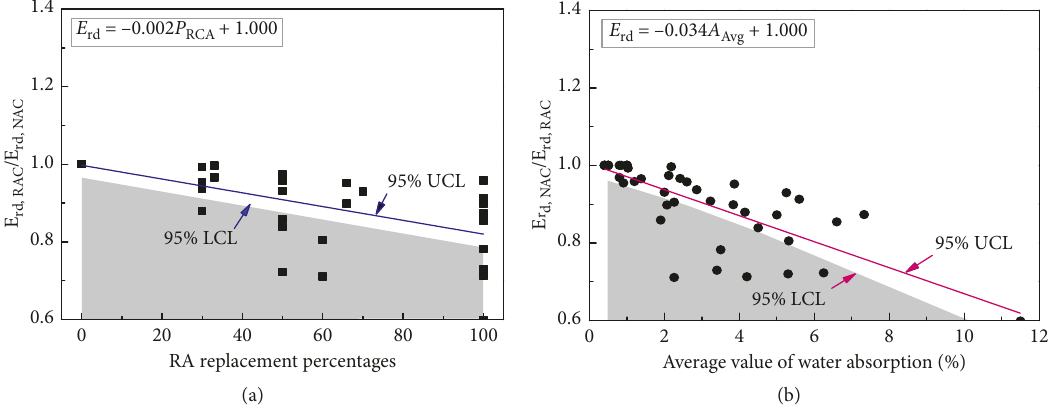
Figure 10: Relative dynamic elastic modulus of concrete with (a) various contents and (b) various average water absorption rates of